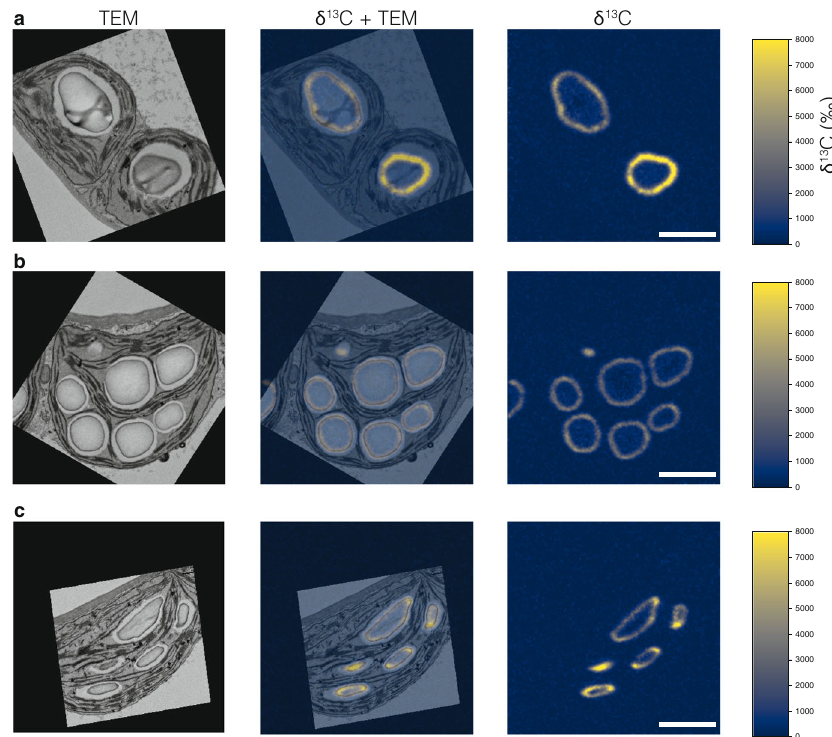
Fig. 5 Starch granule initiation and growth are controlled by STARCH SYNTHASE 4. Plants subjected to a normal night were labeled with a pulse of 13 CO 2 for 1 h at midday then harvested immediately for EM and NanoSIMS imaging, as in Fig. 3. a Chloroplasts from the ss4 mutant. b Chloroplasts from the ss4 mutant expressing a self-glycosylating glycogen synthase (GS) from A. tumefaciens . c Chloroplasts expressing the GS fused with the N-terminal of SS4. Scale bars: 2 µ m. For additional examples, see supplementary Fig. 2g – i. For analysis of the patterns of 13 C-enrichment, see Supplementary Fig.